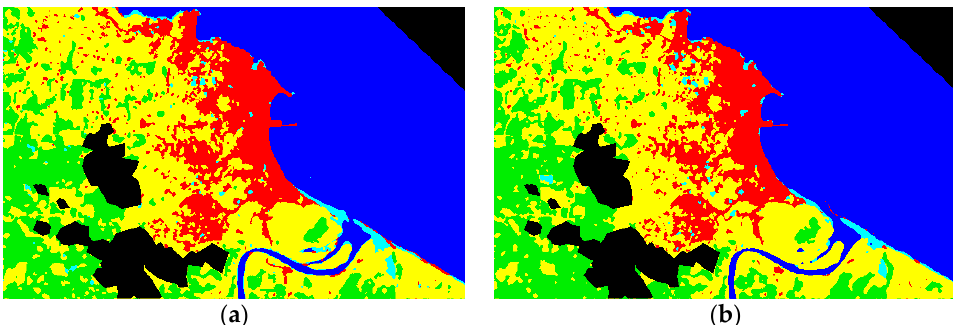
Figure 8. Classification maps obtained on the “Jérémie 2017”, “Jérémie 2018”, and “Jérémie 2019” datasets: ( a ) classification map corresponding to 2018; ( b ) classification map corresponding to 2019. For the legend of the thematic maps, we refer to Table 2. Black pixels indicate unclassified areas where no data were available (e.g., cloud masking or out of the satellite footprint).